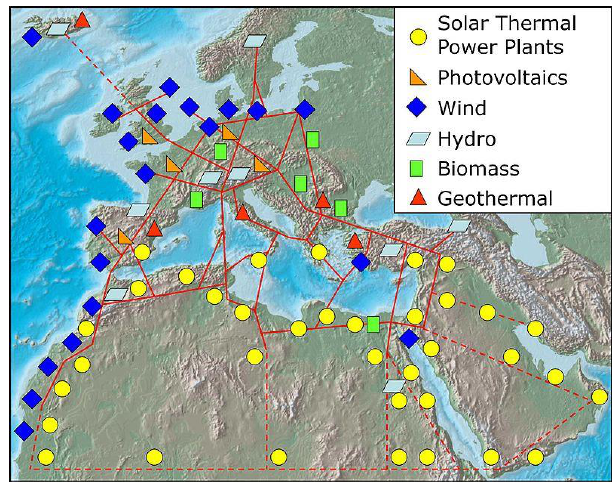
Figure 1. European Super Smart Grid conceptual plan [1] .